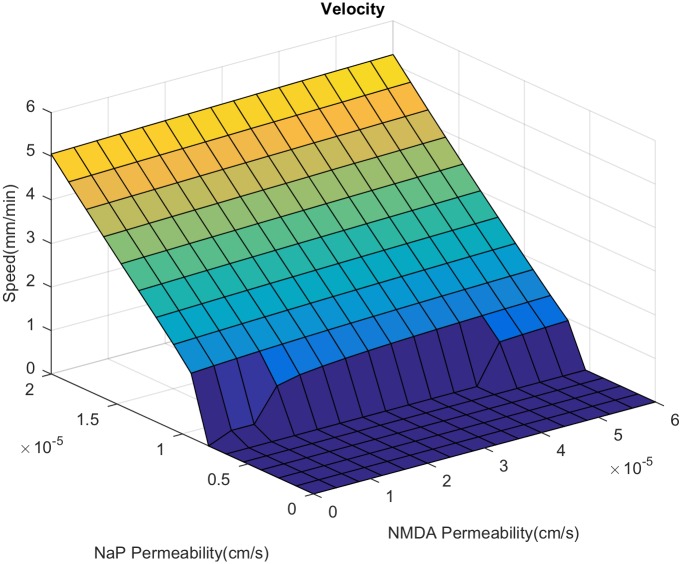
Velocity of spreading depression without glutamate diffusion.Varied over a range of PNaP and PNMDA.